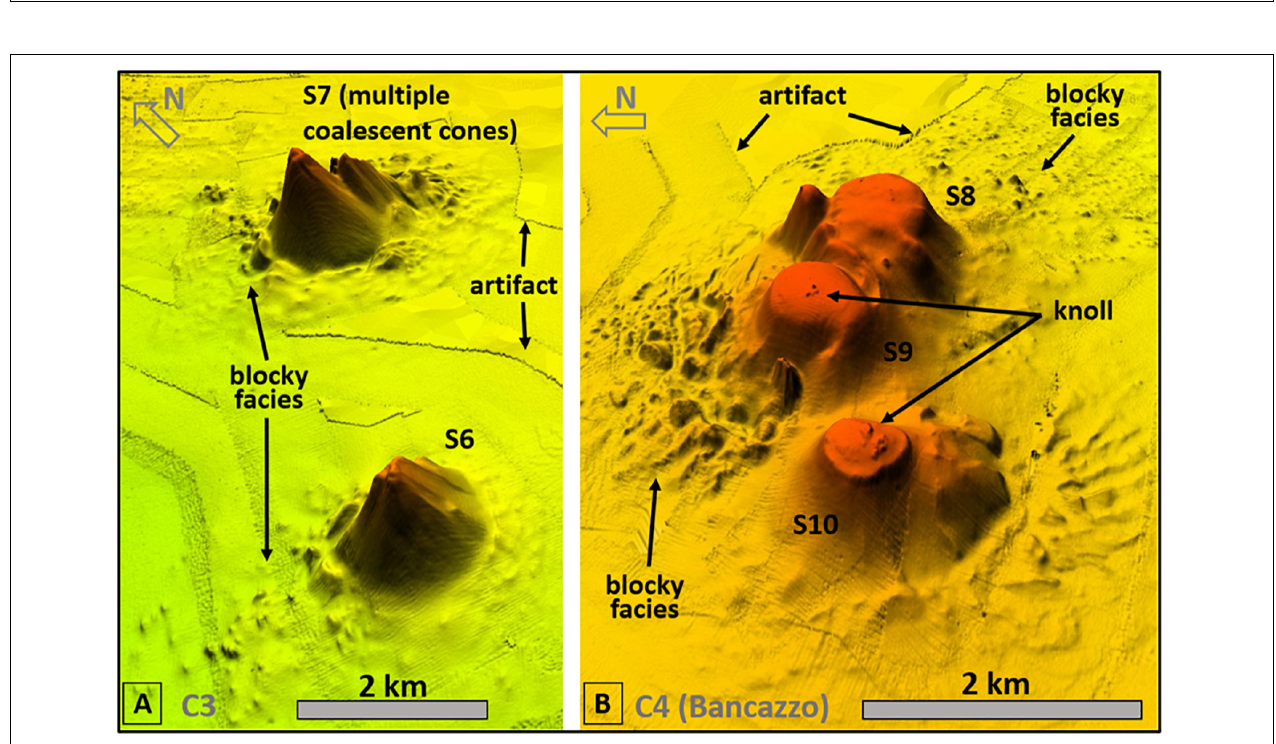
FIGURE 8 | 3D view (vertical exaggeration = 4x) of (A) C3 Cluster – (B) C4 cluster (Bancazzo).